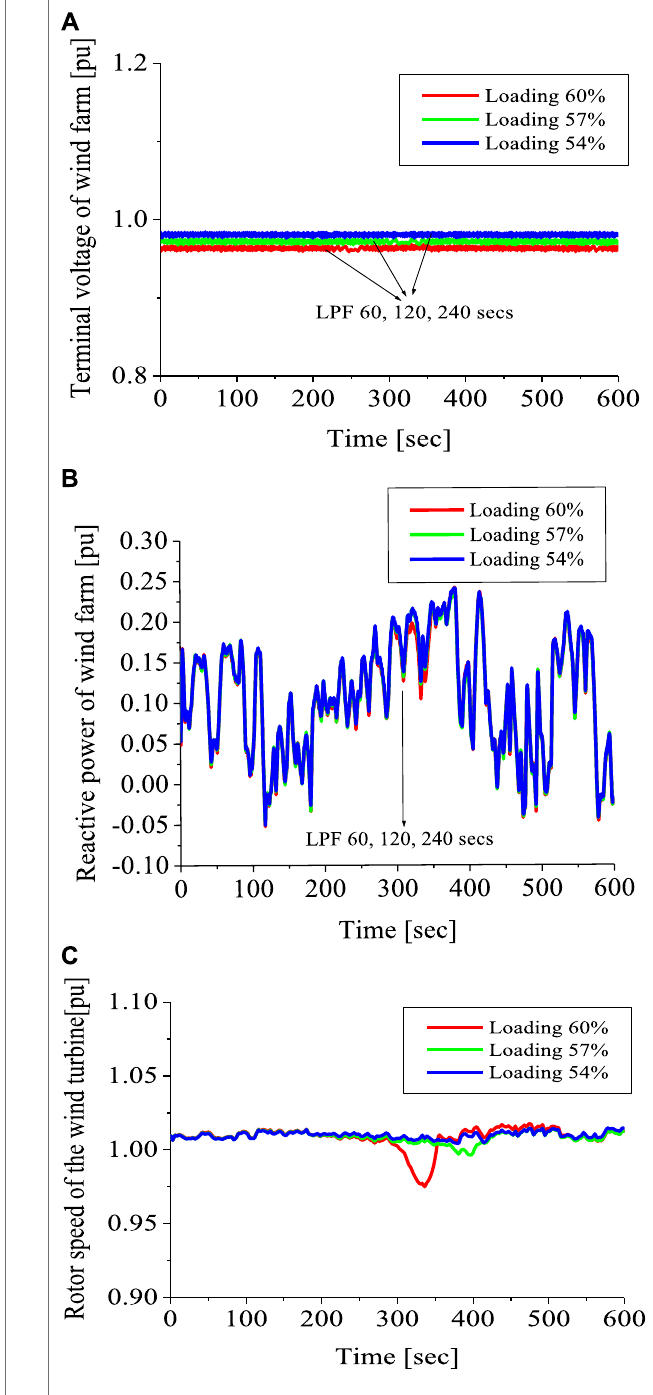
FIGURE 8 | Dynamics of the variables of the wind farm. (A) Terminal voltageofthewindfarm. (B) Reactivepowerofthewindfarm. (C) Rotorspeed of wind turbine. FIGURE7| Dynamicsofthevariablesofthegrid. (A) Activepower ofthe